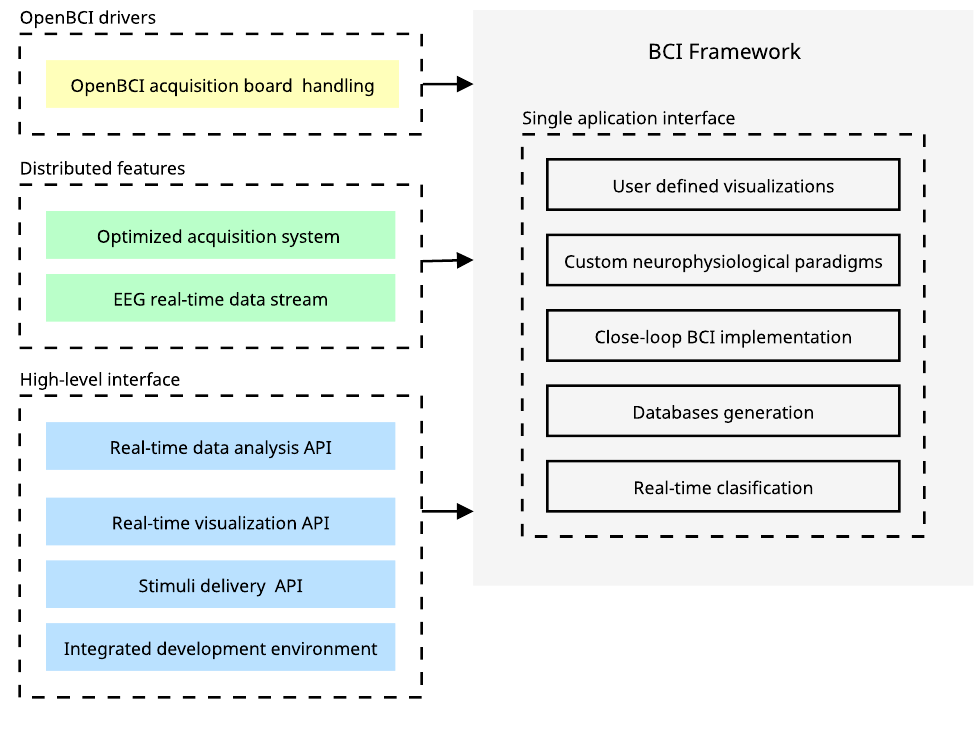
Figure 6. Proposed BCI tool based on OpenBCI (hardware/software) and EEG records. Our approach implements an end-to-end application. Beyond that, the synergy between this characteristic allows the achievement of advanced features that merge the data acquisition with the stimuli delivery in a flexible development environment. The yellow issue is related to the development of custom drivers for OpenBCI; the green ones refer to the integrations over distributed systems; and the blue issue refers to the high-level implementations of utilities served through the main interface.